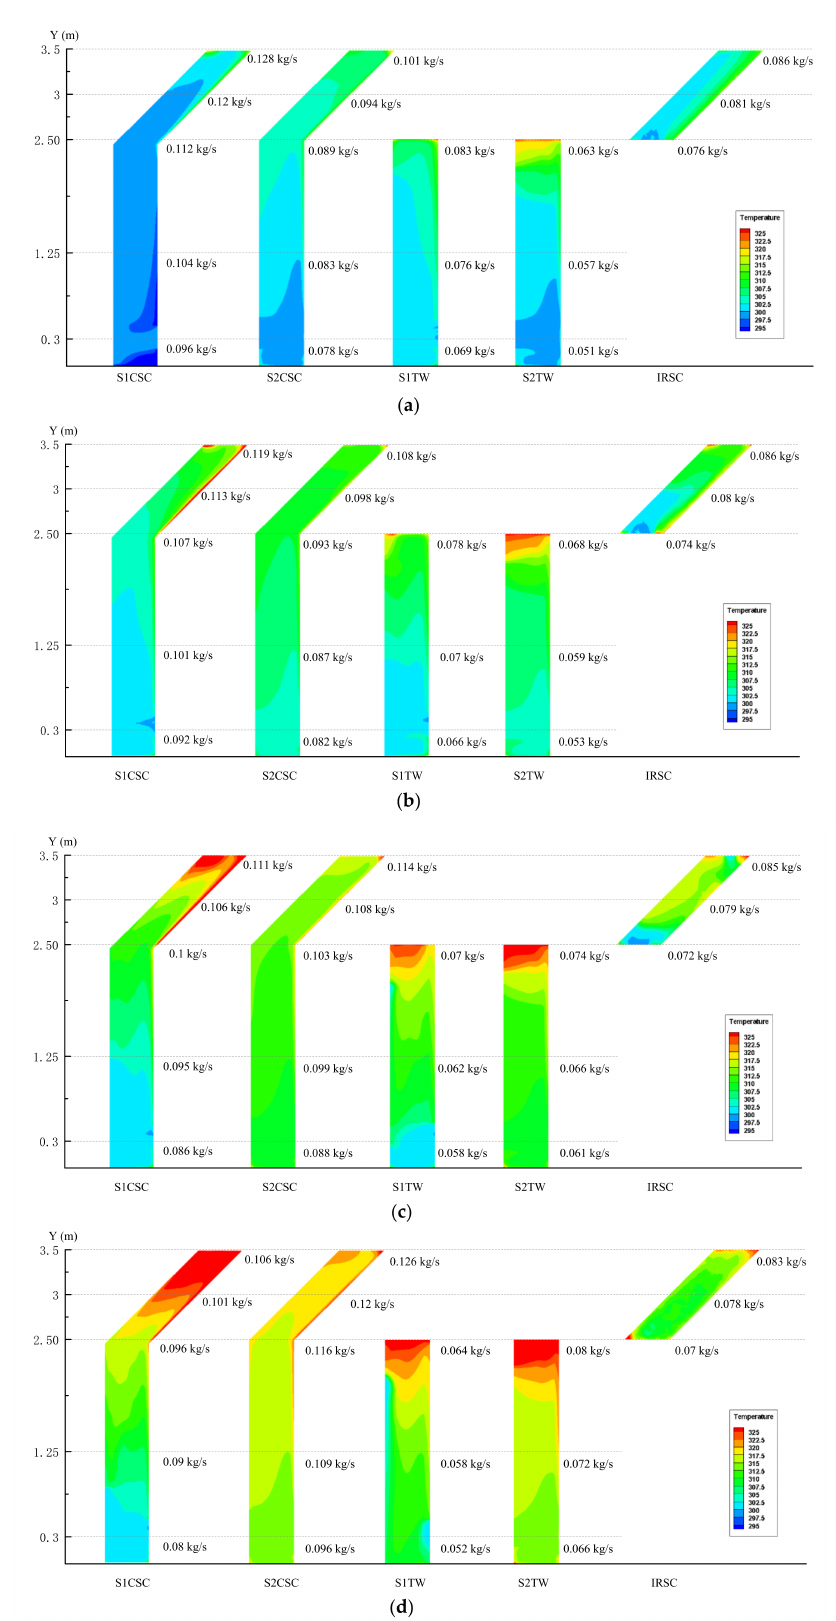
Figure 4. Temperature distributions and the mass flow rate under different ambient temperatures in the summer: ( a ) T a = 298 K; ( b ) T a = 303 K; ( c ) T a = 308 K; and ( d ) T a = 313 K. (For all heat maps, the left boundary is the glass cover and the right boundary is the